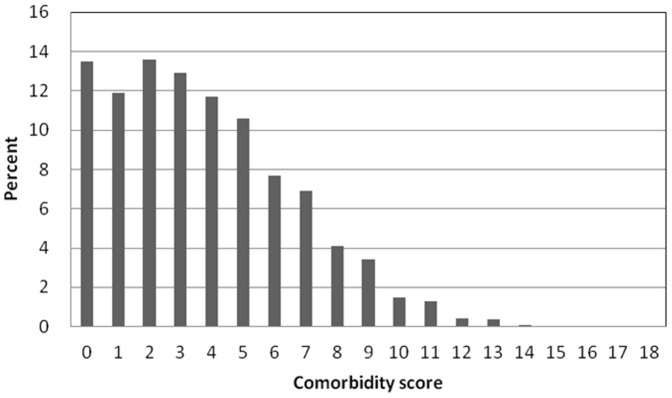
Distribution of elderly dialysis patients by comorbidity score.